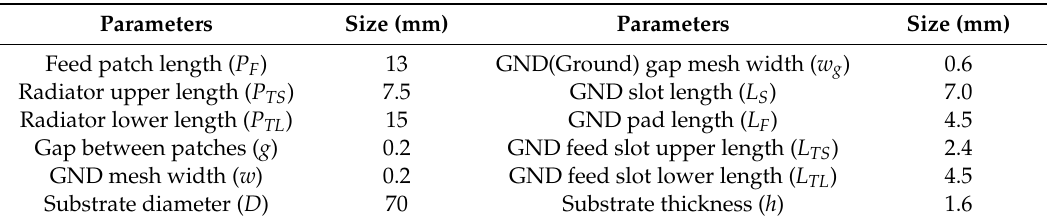
Table 1. Optimized dimensions of the proposed antenna.